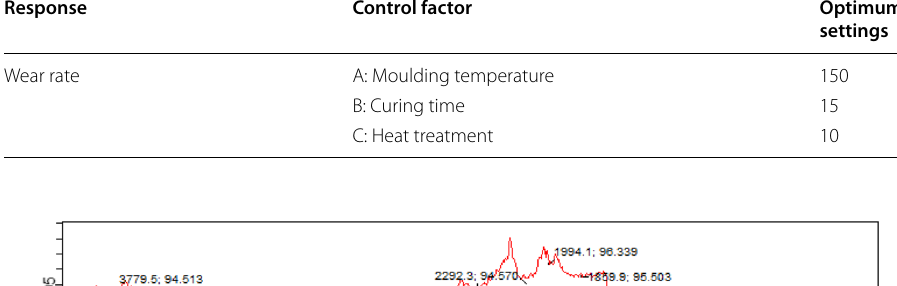
Table 8 Optimal settings for control factors Response Control factor